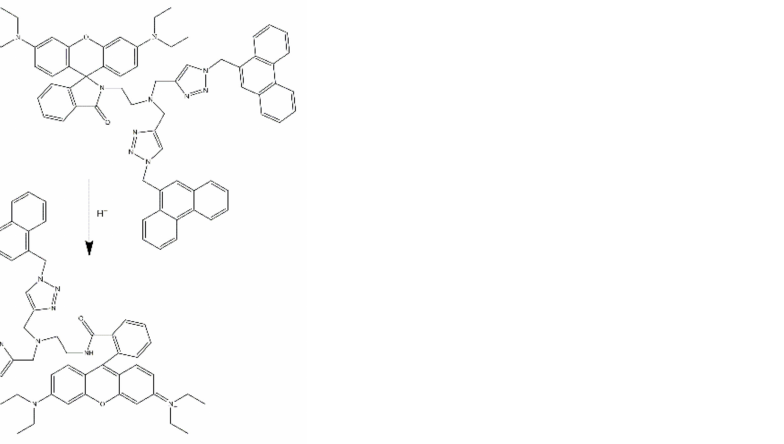
Figure 39. The possible sensing mechanism of the prepared sensor (Table 2, No. 7) for pH [82].